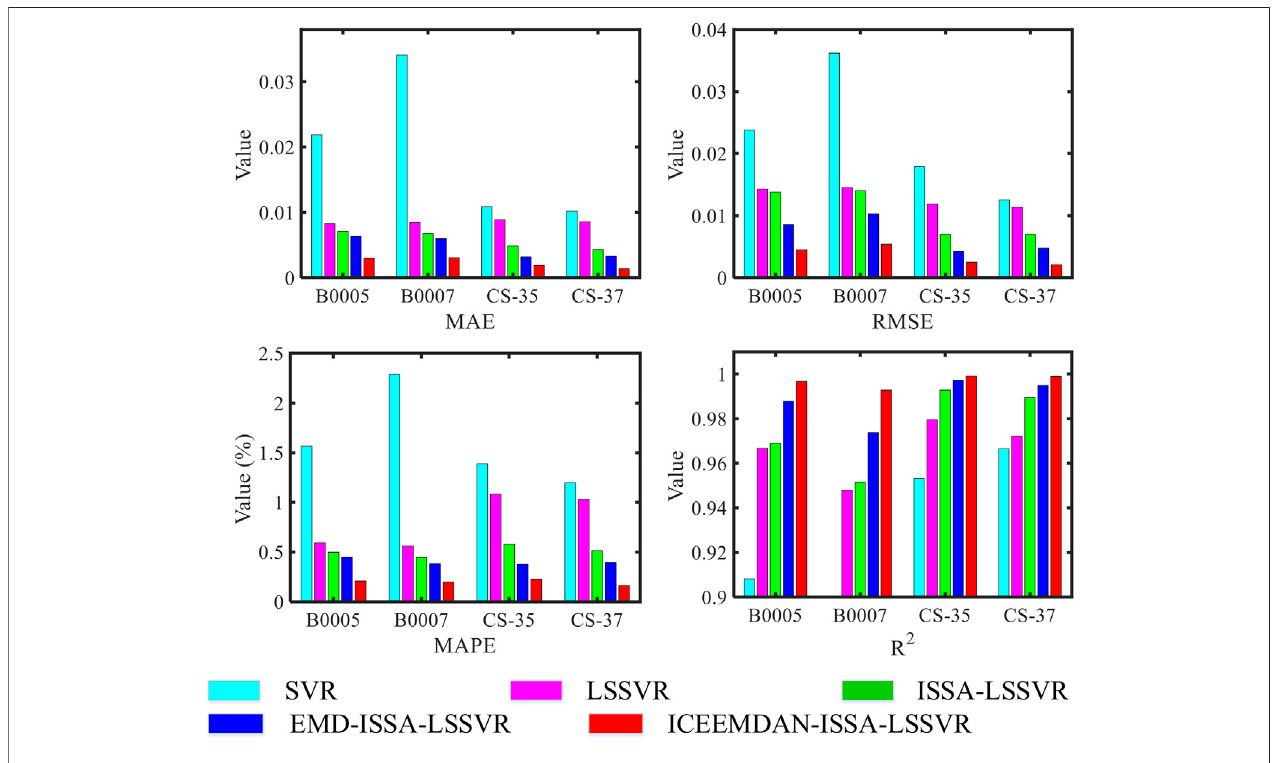
FIGURE 4 | Error metrics of the prediction